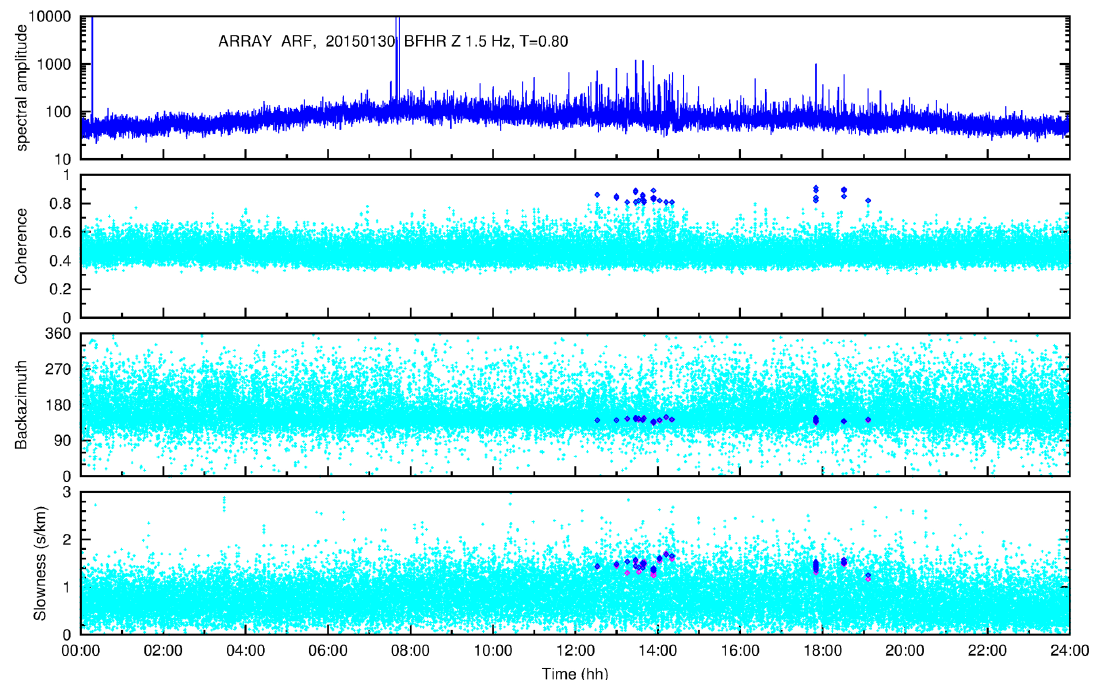
Figure 6. Example of day long results of BF and HR analysis at ARF array for the day January 30, 2015. Top plot shows the average spectral amplitude, then coherence, backazimuth and slowness are shown in the following plots. Results of the windows with coherence greater than 0.8 are shown by blue (BF) and magenta (HR) symbol to make them more visible among the background